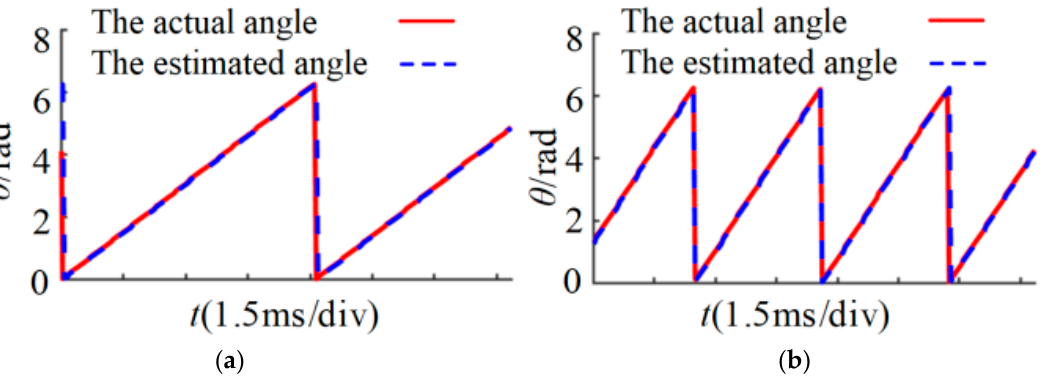
Figure 10. The estimated angle curve under the loading and rotational speed mutation conditions. ( a ) Load. ( b ) Speed mutation .